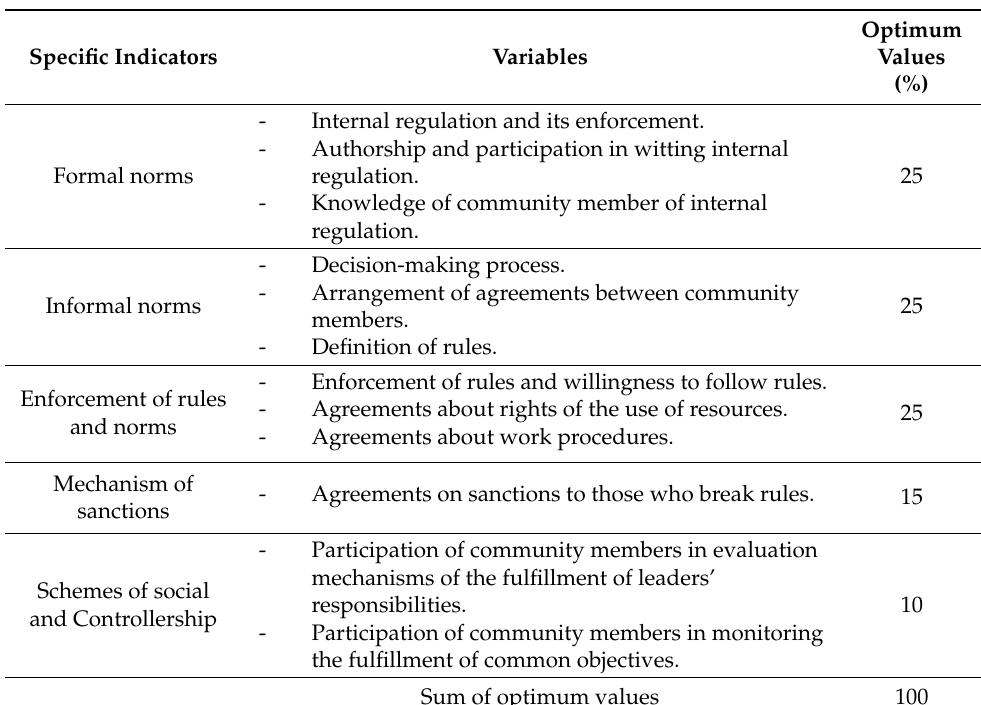
Table 4. Specific indicators and variables of collective